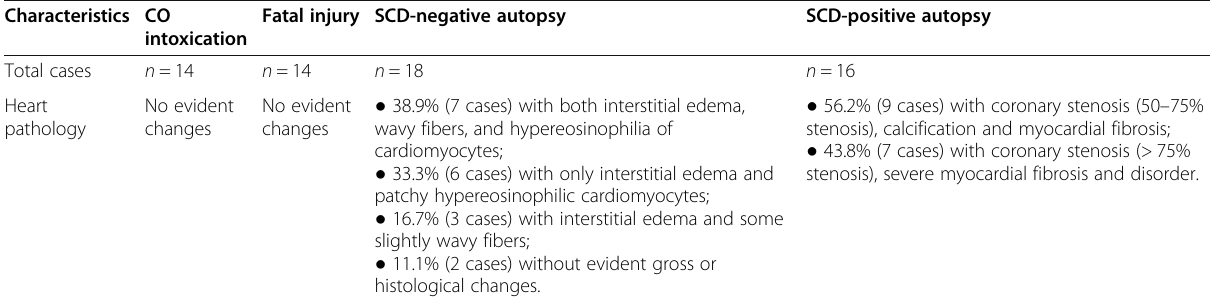
Table 2 Heart pathology in the SCD-negative autopsy, SCD-positive autopsy, and control groups (CO intoxication and fatal injury) Characteristics CO Fatal injury SCD-negative autopsy intoxication